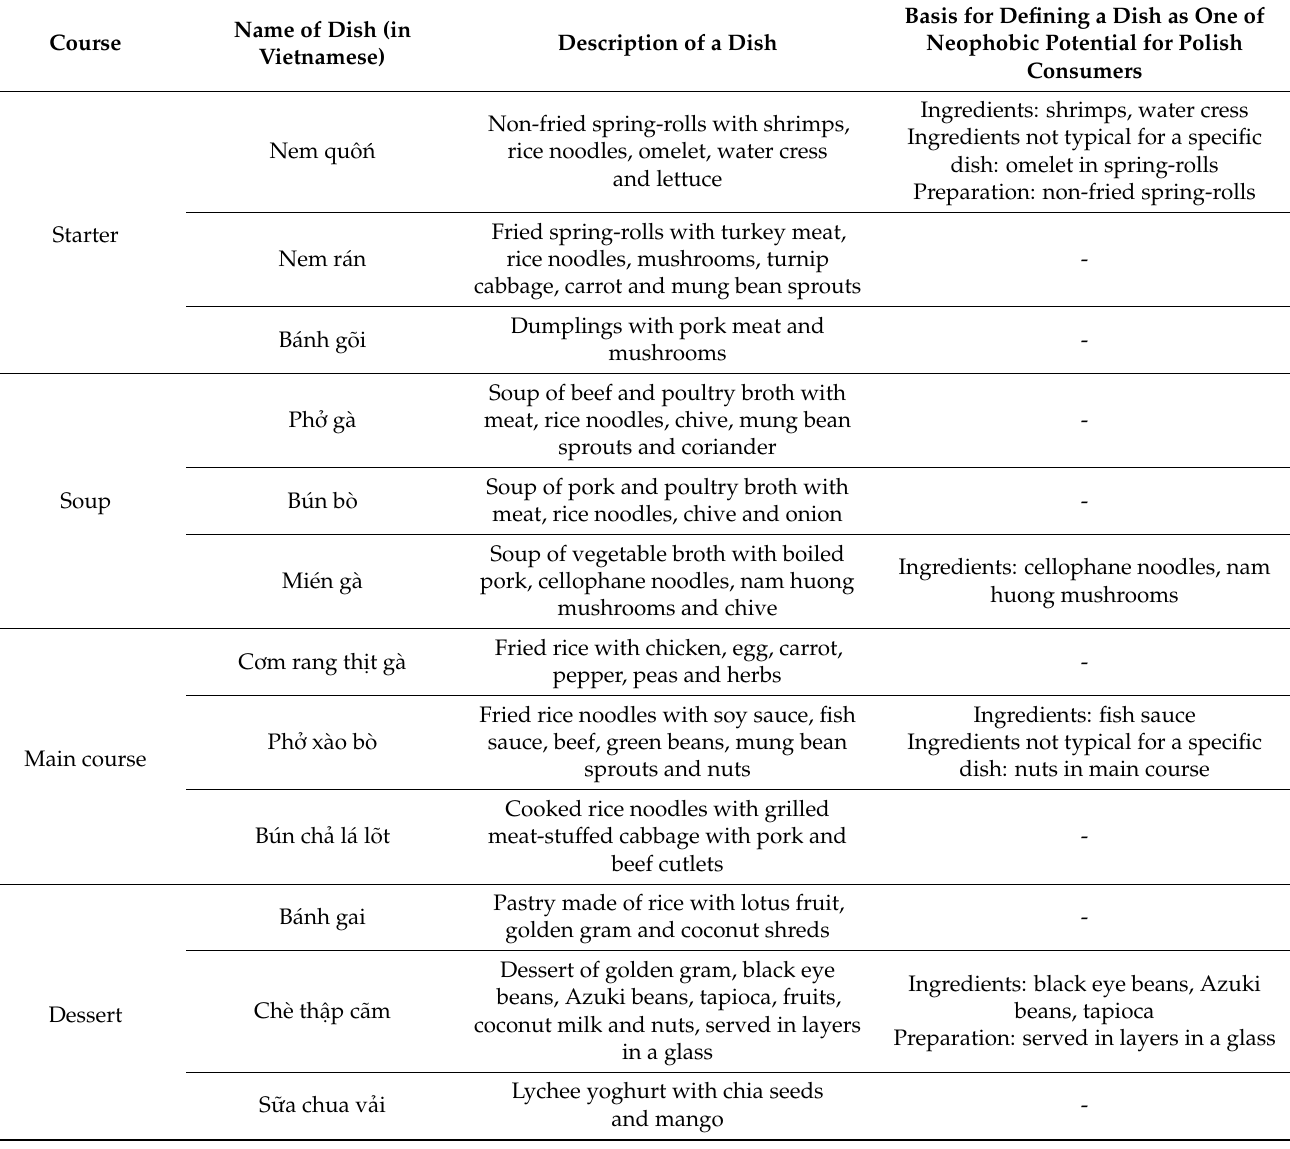
Table 1. The dishes included to the developed Vietnamese model restaurant menu with their descriptions and defined neophobic